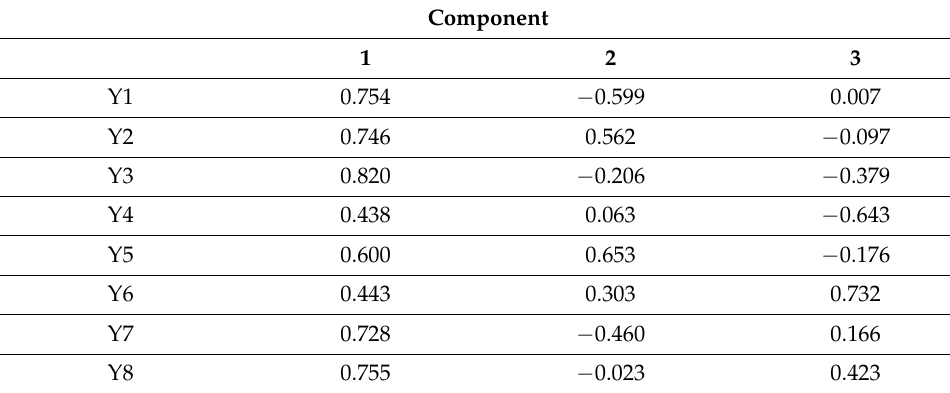
Table 3. Component